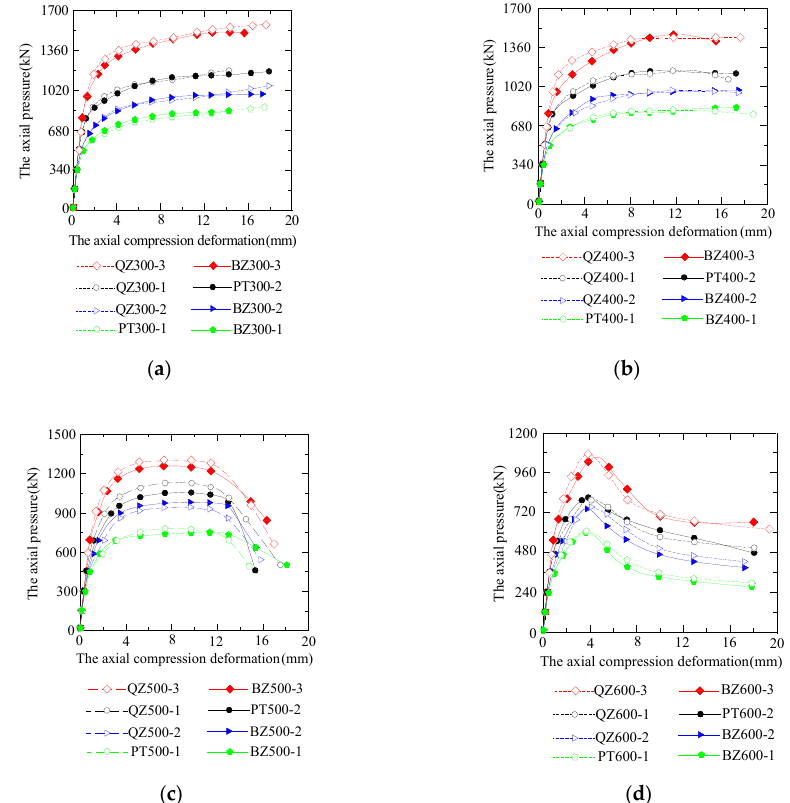
Figure 5. The load–displacement curve: ( a ) λ = 2.6; ( b ) λ = 3.5; ( c ) λ = 4.4; ( d ) λ = 5.3.